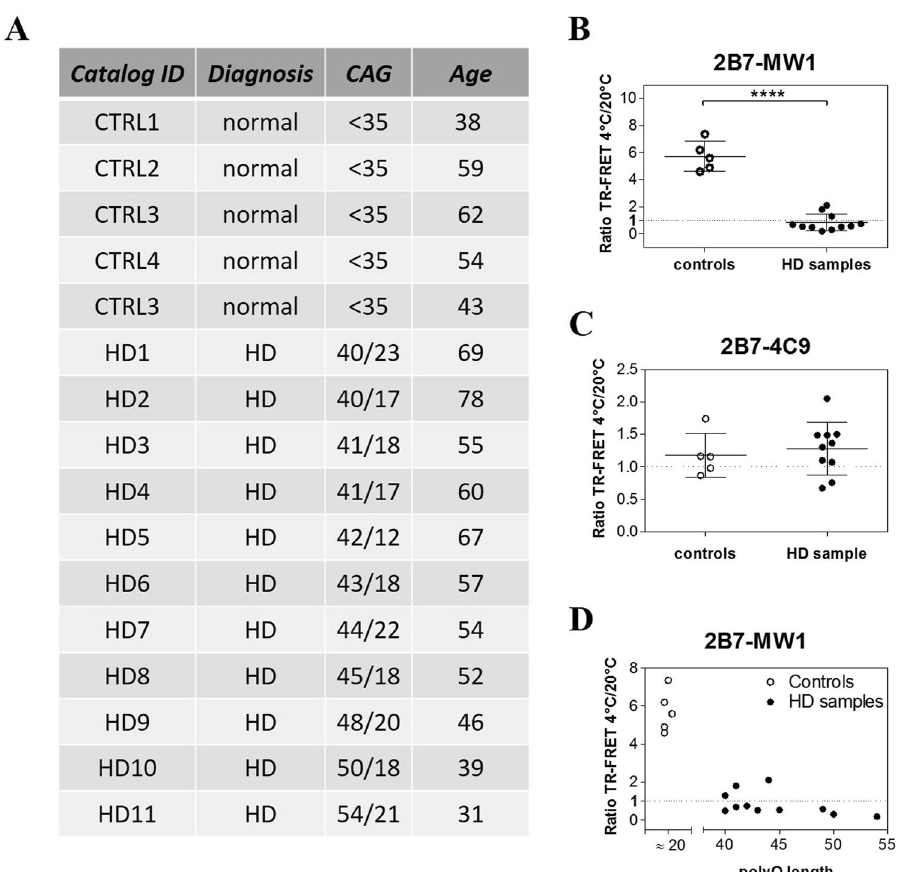
of smaller differences in conformation which might be difficult to detect in more complex samples (such as total lysates of cells). We elected to employ HTT exon 1 sequences bearing polyQ lengths of Q22 (representative of wild type HTT) and Q43, representative of a common mutant allele in HD 42, 43 . All semisynthetic proteins, either without or with phosphorylation and position S13, S16, S13 and S16 or bearing phosphomimetic (S → D) muta- tions at these positions for comparisons, were produced and quality controlled as described 34 . The HTT proteins were first resuspended with great care from lyophilized batches to reduce aggregation, and then examined by standard Western blotting (Fig. 9A). Although some evidence of protein aggregation was observed (variable amounts of immunoreactive material in the wells; Fig. S4), the vast majority of the HTT protein was resolvable on SDS-PAGE. Samples were then subjected to TR-FRET analysis using the 2B7/MW1 and 2B7/4C9 immunoassays at the two temperatures. As 2B7 recognizes an epitope within the N17 region of HTT, the 2B7/4C9 immuno- assay served both as a conformational immunoassay control as well as a control TR-FRET assay for detecting interference with HTT N17 detection by 2B7 caused by S13/S16 phosphorylation. As shown in Figs 9B and 10A, both immunoassays efficiently detected the semisynthetic HTT proteins, with the expected temperature- and polyQ-dependent shift in TR-FRET signal produced by the 2B7/MW1 immunoassay (Fig. 9B) but not by the 2B7/4C9 assay (Fig. 10A). For simplicity, data pertinent to the analysis of HTT exon 1 peptides (Q22 and Q43) bearing no phosphorylation or the compound S13/S16 phosphorylation are shown. When the datasets obtained at the two temperatures with the 2B7/MW1 immunoassay were analyzed to investigate conformational effects, no significant variations arising from either single or compound phosphorylation at S13/S16 were observed for the wild type (Q22) HTT exon 1 protein, as was also the case for the single or compound phosphomimetic (S → D) mutations (Fig. 9C). Interestingly, however, a significant effect of the compound (S13 and S16) phosphorylation or the corresponding compound phosphomimetic mutations was observed when the 2B7/MW1 TR-FRET data- sets relevant to the mutant (Q43) HTT protein were analyzed (Fig. 9D). The apparent effect of the compound